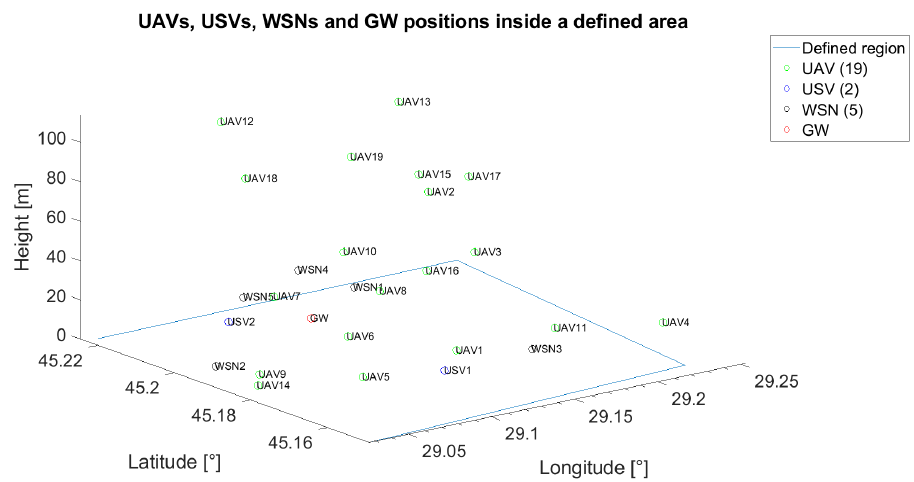
Figure 11. Initial positions before applying the